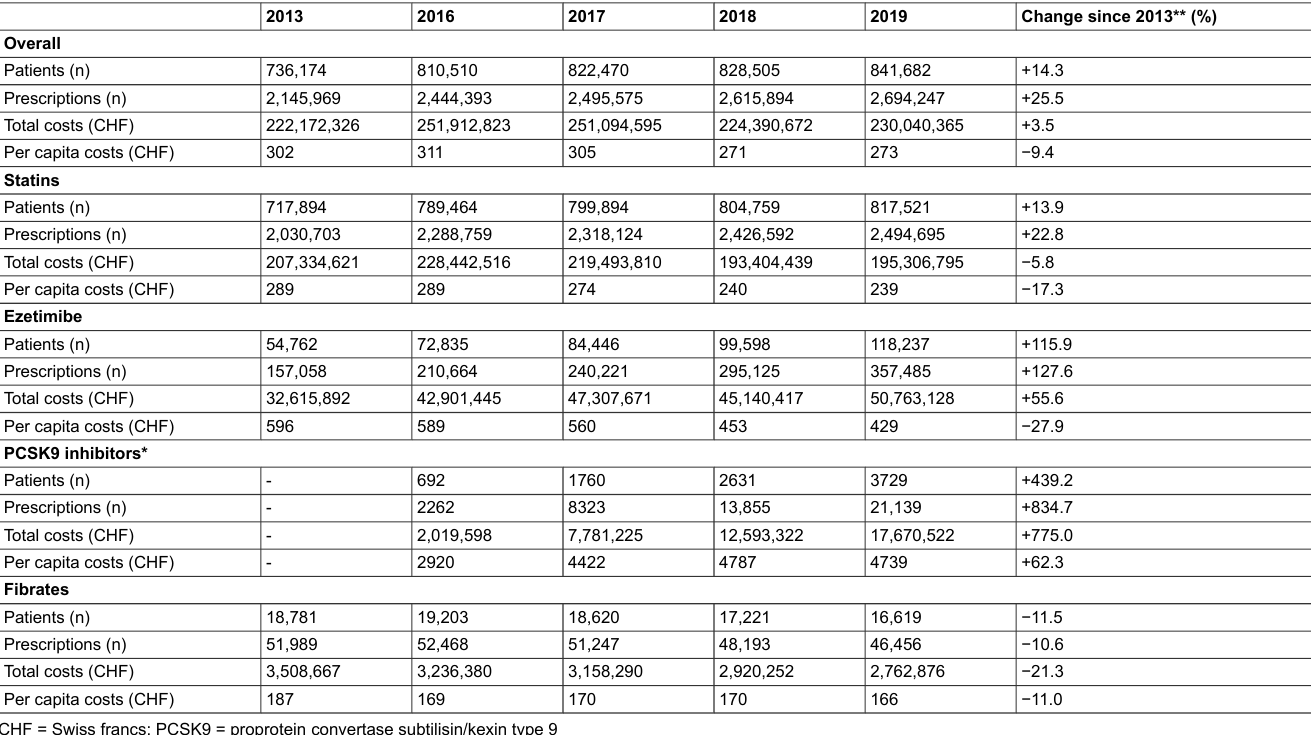
Table 3: Patients with filled prescriptions, filled prescriptions, and costs of lipid-lowering drugs between the years 2013 and 2019, by drug class, extrapolated to the Swiss population lev- el